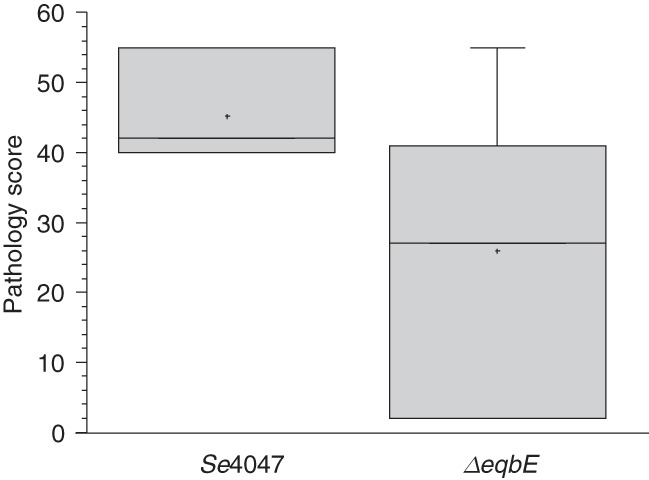
Pathology score of two groups of seven Welsh mountain ponies challenged with wild-type Se4047 or the ΔeqbE deletion mutant. The box illustrates the 50% distribution, the line indicates the median value, the cross indicates the mean, and error bars indicate the maximum and minimum distribution.